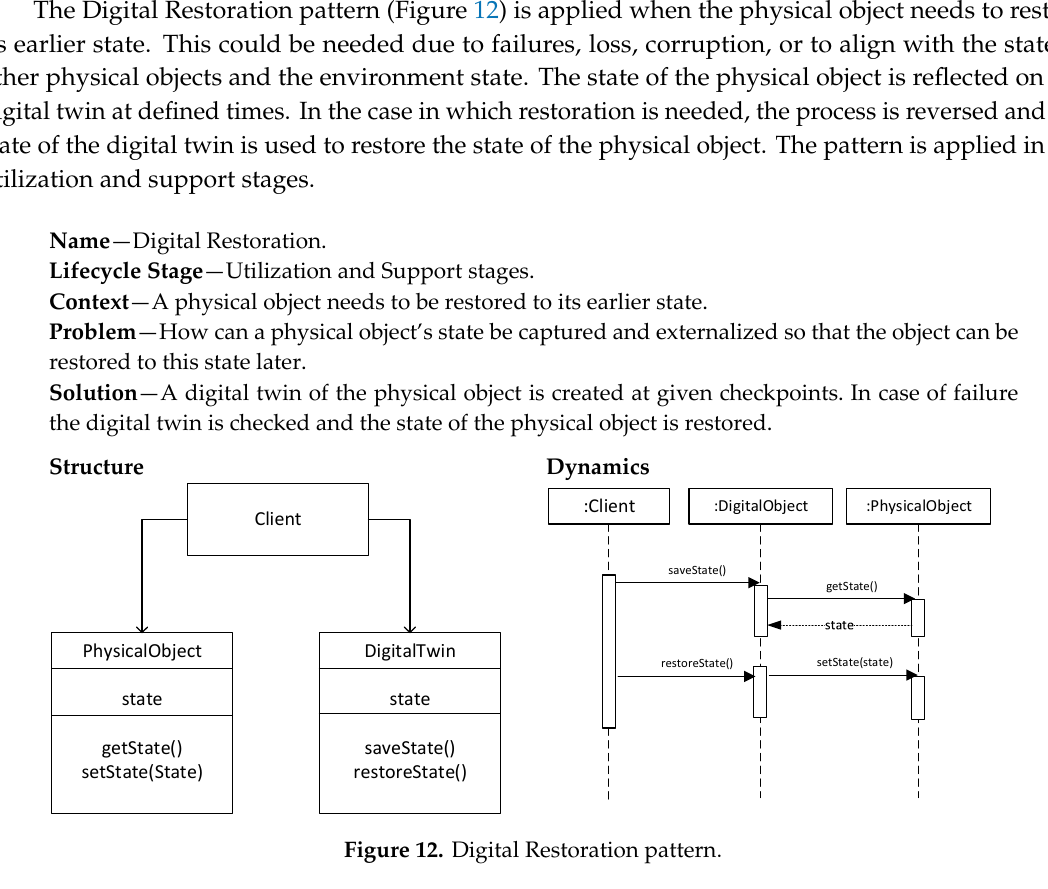
Figure 12. Digital Restoration pattern.